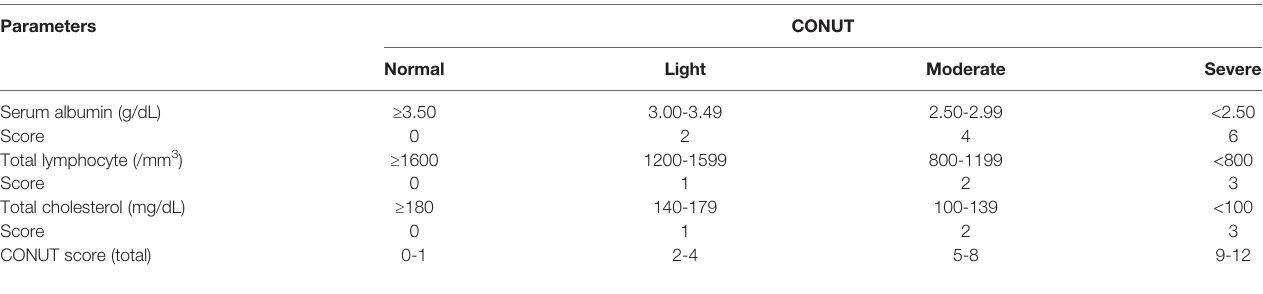
TABLE 1 | De fi nition of CONUT